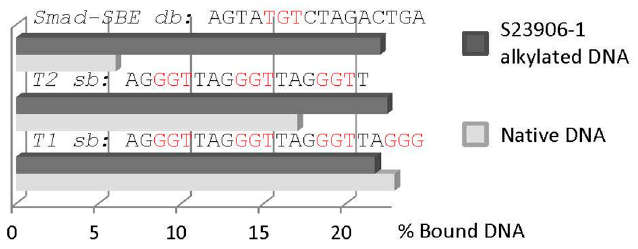
Figure 6. Histogram of the quantification of GAPDH bound to S23906-1/DNA adducts or native DNA. Two single stranded telomeric sequences were used (T1 and T2) in comparison with the double-stranded Smad-SBE oligonucleotide for binding to the same amount of GAPDH. The transcription factor DNA binding sequences are here used as a mixture of a variety of DNA sequences. However, it would be interesting to further evaluate the incidence of GAPDH interaction to some highly recognized sequences in order to precise if GAPDH covering sequences match the identified transcription factor binding site and if GAPDH could compete for this transcription factor